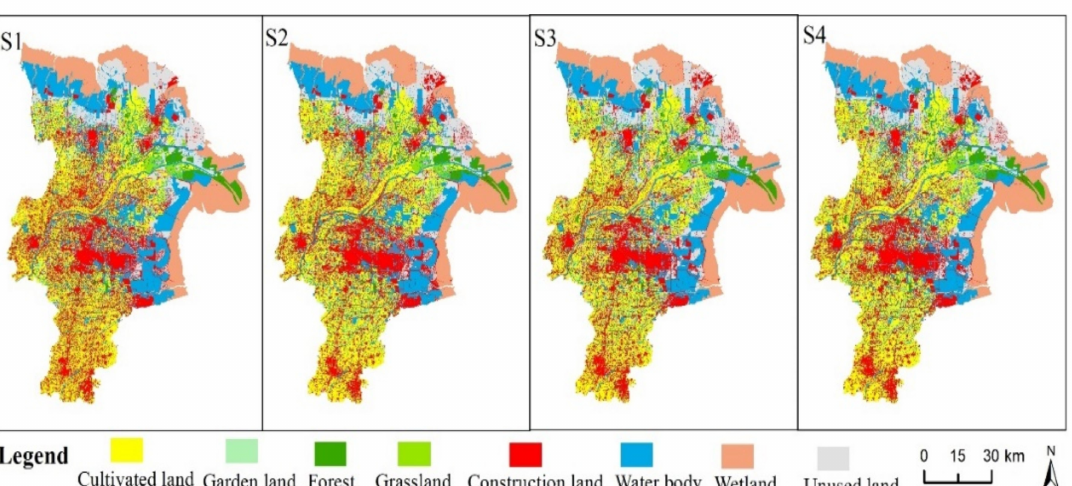
Figure 4. Land use map of 2030 in ( S1 ), ( S2 ), ( S3 ) and ( S4 ). Note: S1, S2, S3 and S4 refer to the business as usual scenario, the fast-cultivated land expansion scenario, the ecological security scenario and the sustainable development scenario, respectively.